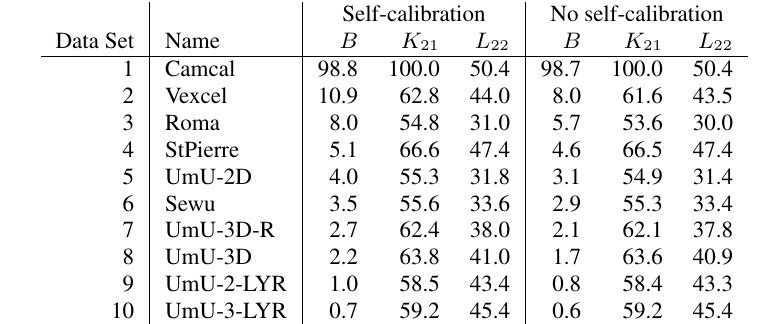
Table 2: Block non-zero density for the data sets. The B column correspond to the B block of the original problem in equations (22) and (5), respectively. The K 21 ( Q ), and L 22 columns are densities for corresponding blocks in the IC algorithm. All recorded K 22 densities were very close to 50%.